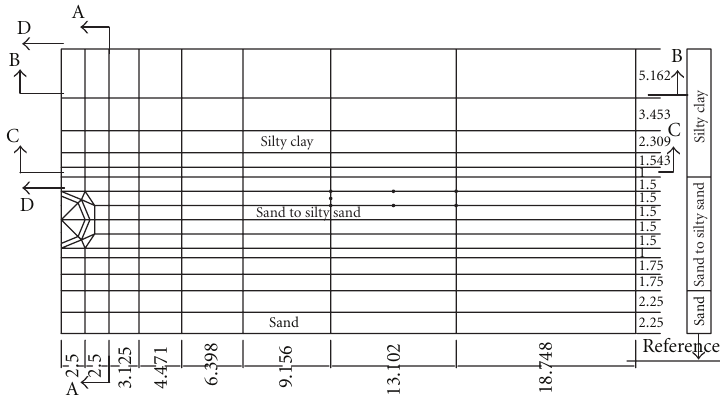
Figure 3: The finite element mesh for the problem.